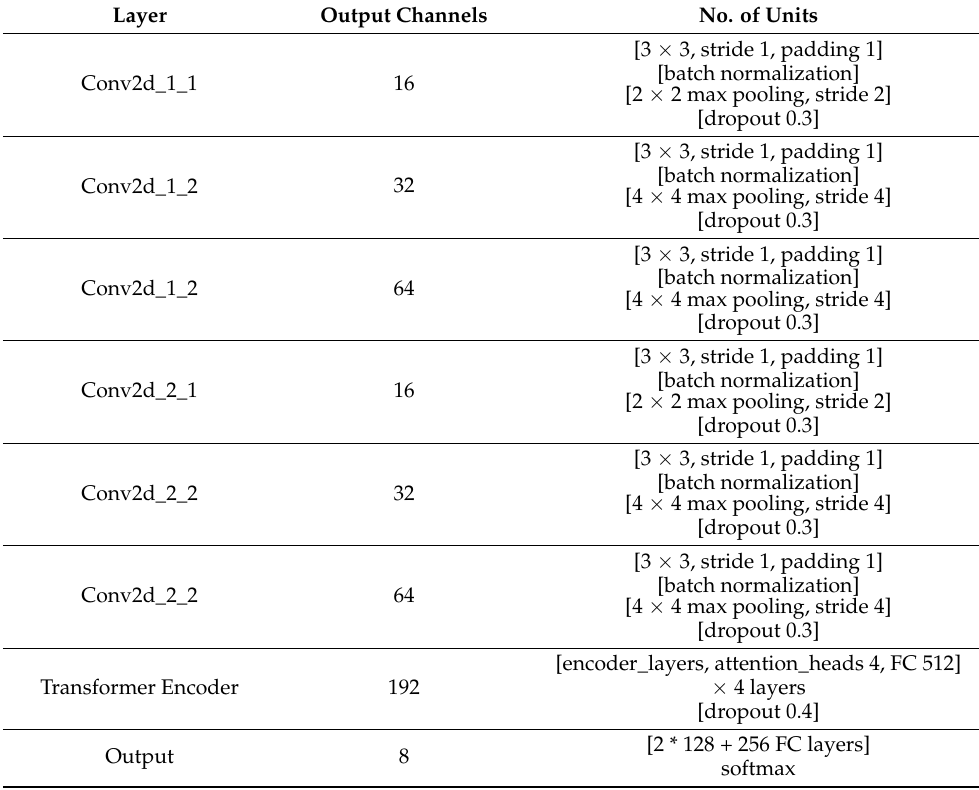
Table 3. Overall specification of Parallel-CNN-Transformer network with set of layer sizes, output sizes, and number of units.